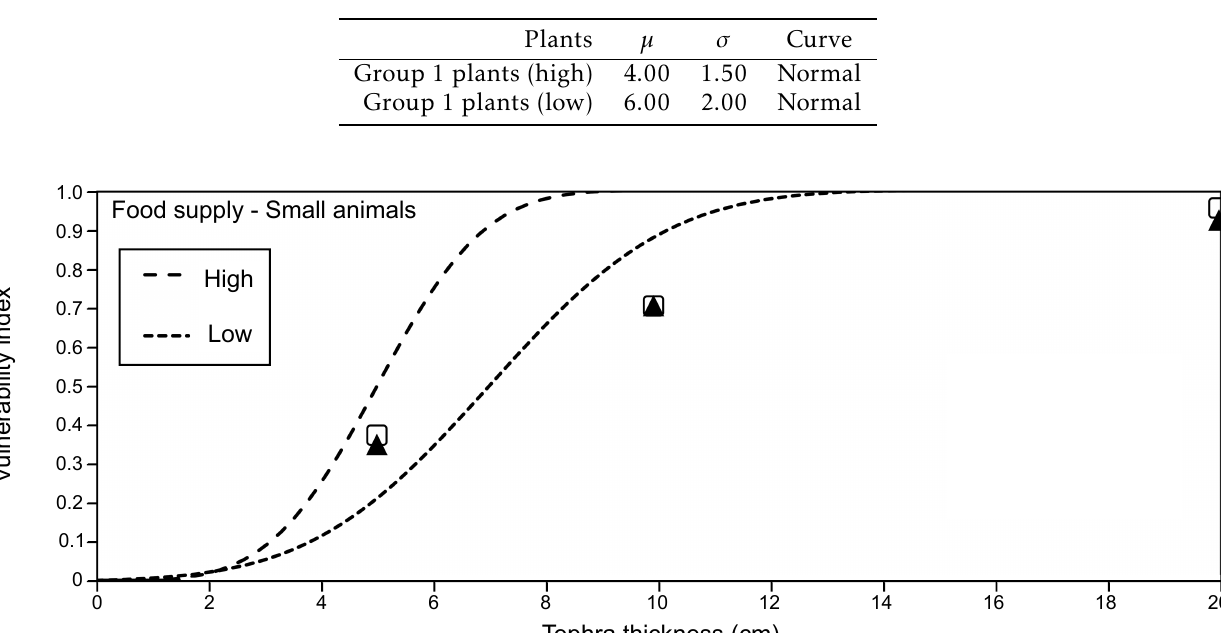
Figure A3: Estimated high and low vulnerability indices for a variety of Group 1 plants exposed to 0–20 cm of tephra fall from the Laacher See eruption. For example, we have chosen to focus only on plants growing reasonably close to the ground although, Following MIA-VITA [Bignami et al. 2012], Group 1 plants are small herbaceous plants and creepers – plants that we believe were the most likely plant food source for Federmesser- gruppen people. Table A3 – Fitting parameters for vulnerability curves based on food supply (plants) in Figure A3.